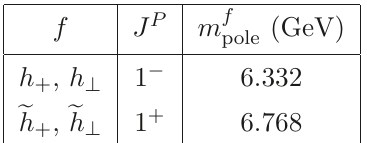
Table 1 . Values of the pole masses for the tensor form factors.